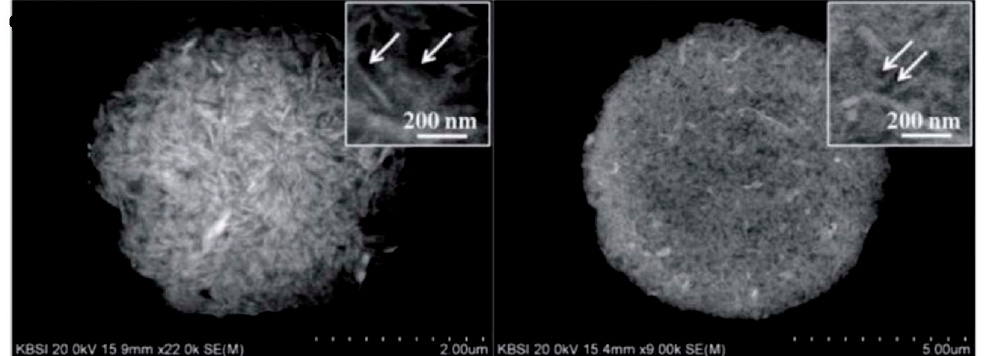
Figure 6. SEM images of cross-sections in ( left ) Co 3 O 4 and ( right ) CoO–carbon composite powders.